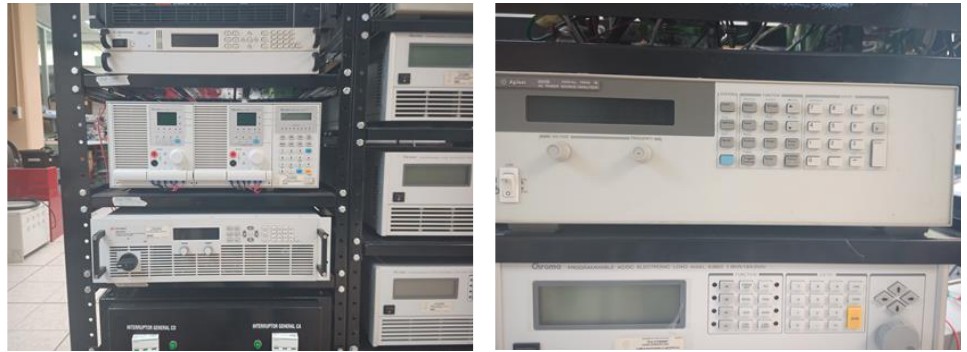
Figure 11. Power supplies used.